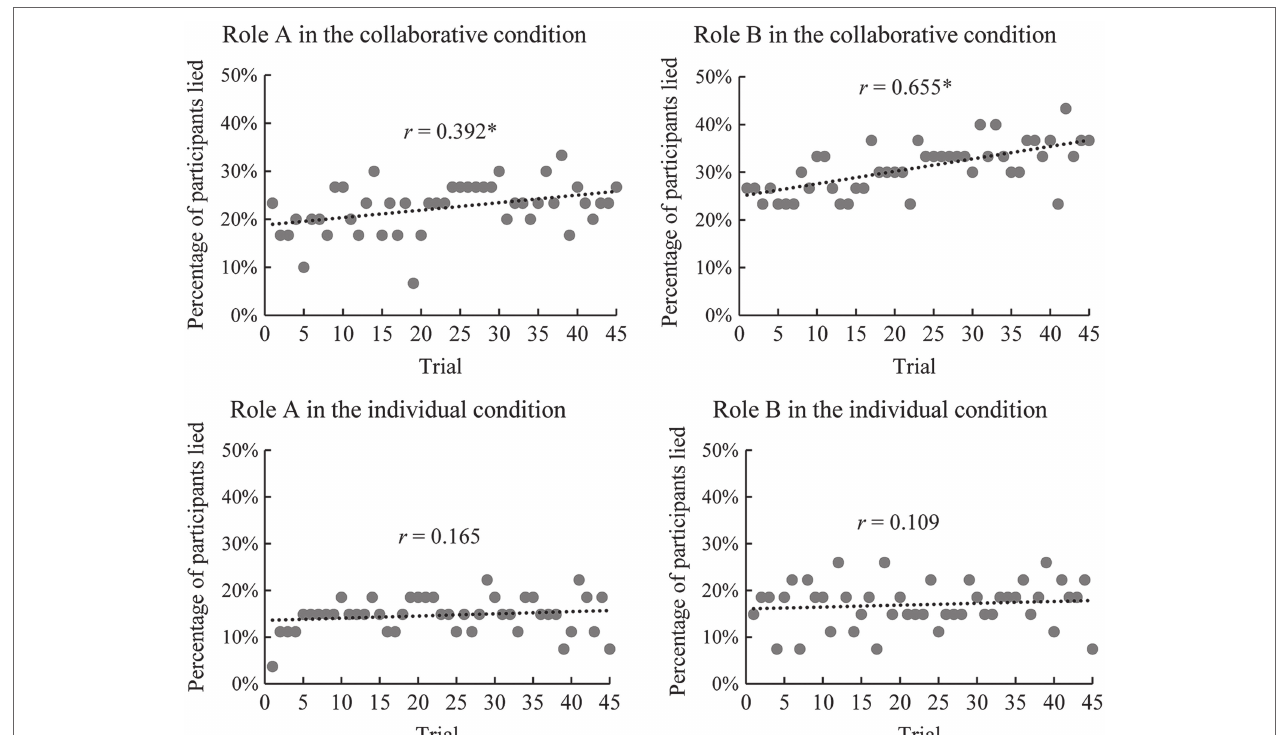
FIGURE 6 | Scatter plots of the percentage of participants who lied in each trial. * p <